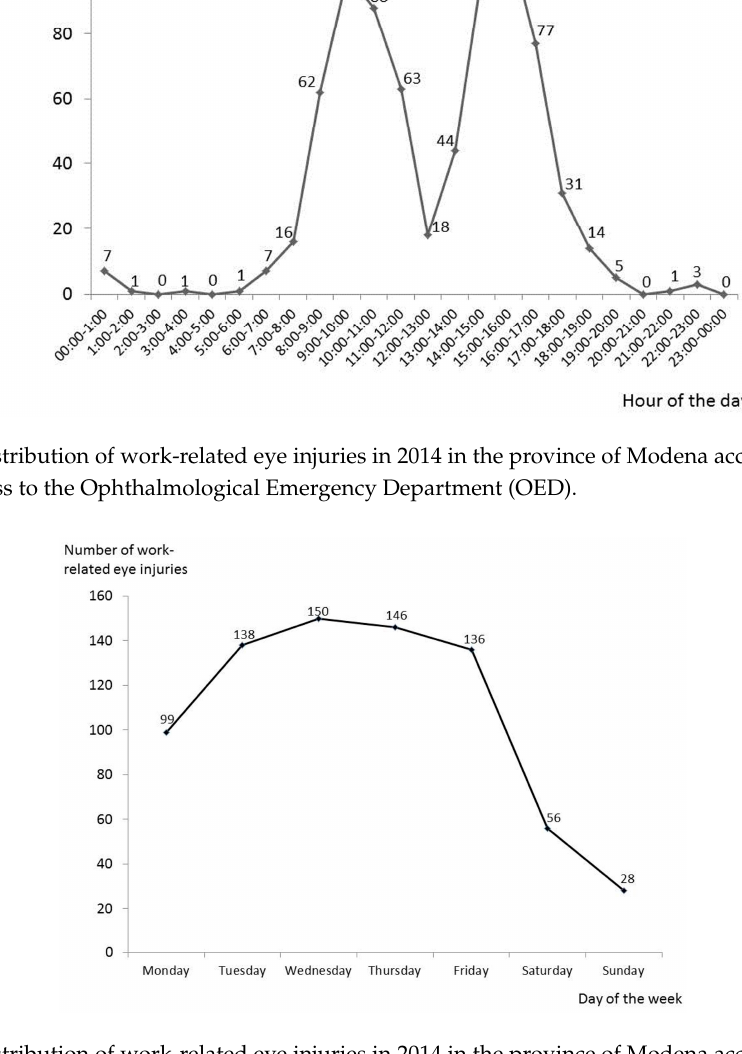
Figure 3. Distribution of work-related eye injuries in 2014 in the province of Modena according to the day of access to the Ophthalmological Emergency Department (OED).